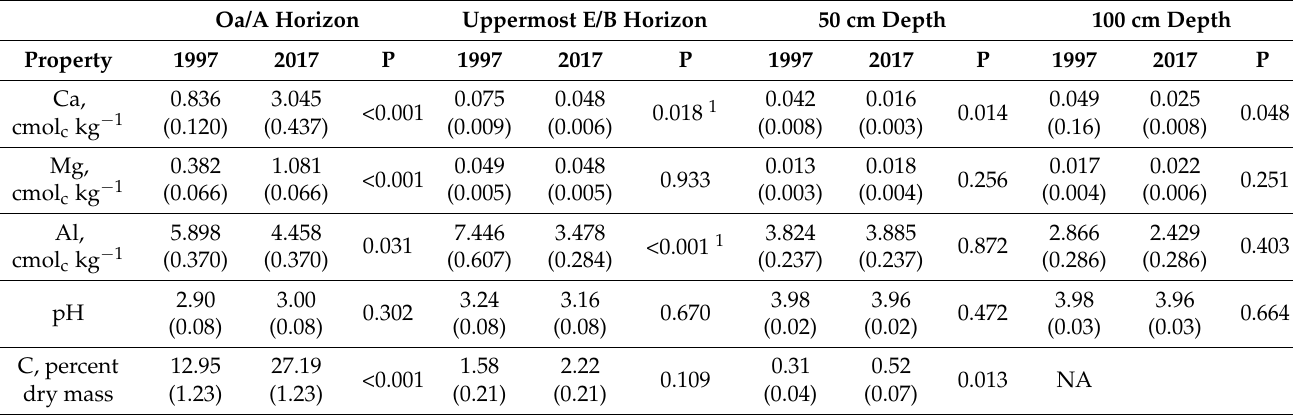
Table 1. Least squares means (standard error) for exchangeable element concentrations of Ca, Mg, Al, and pH, and C for the Oa/A, upper mineral horizon (E/B), B at 50 cm depth and B/C at 100 cm depth in 1997 and 2017. Sample number is 16 for each comparison (4 sites × 4 pits per site).